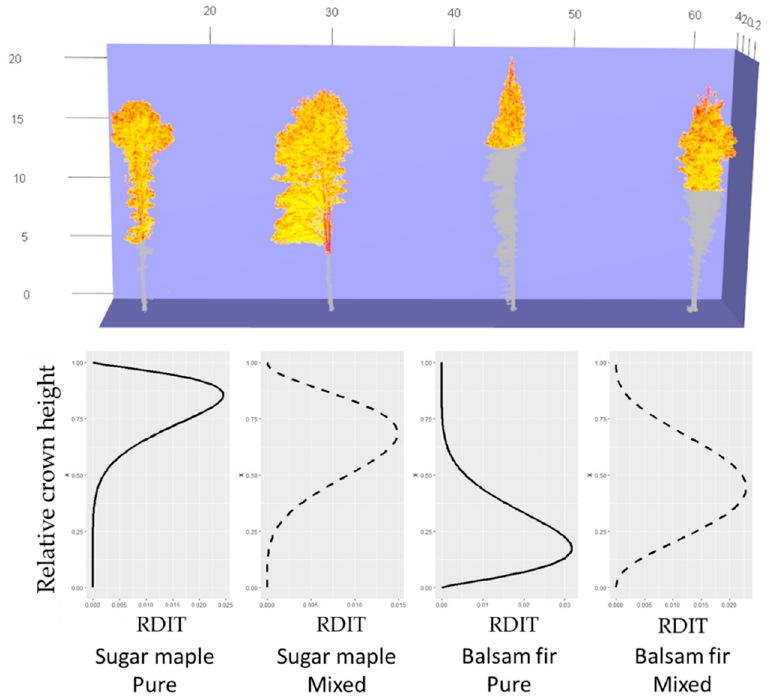
Figure 6. Four example trees and their associated RDIT profiles. From left to right a sugar maple in pure stand; a sugar maple in mixed stand; a balsam fir in pure stand and a balsam fir in mixed stand. On the upper part, the voxel of the crown is represented with a color gradient from yellow to red for RDIT values (similar to Figure 2). The grey parts of the trees are the trunk and the dead branches (not considered for the profile). On the lower part the RDIT profile of each tree is represented.